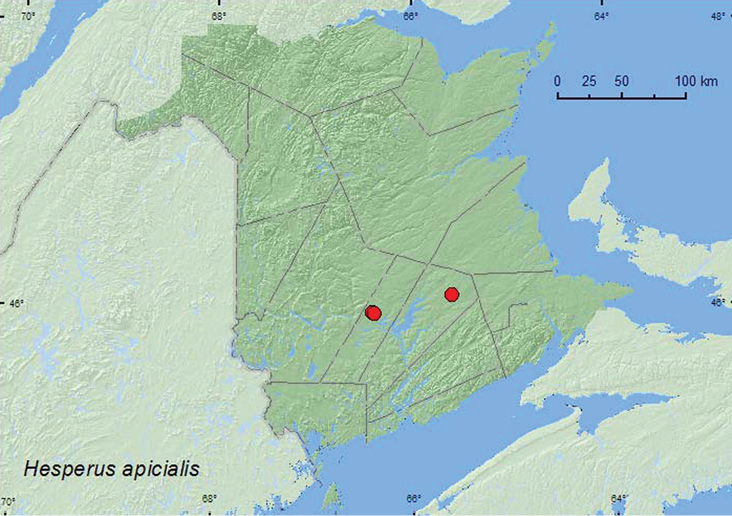
Collection localities in New Brunswick, Canada of Hesperus apicialis.